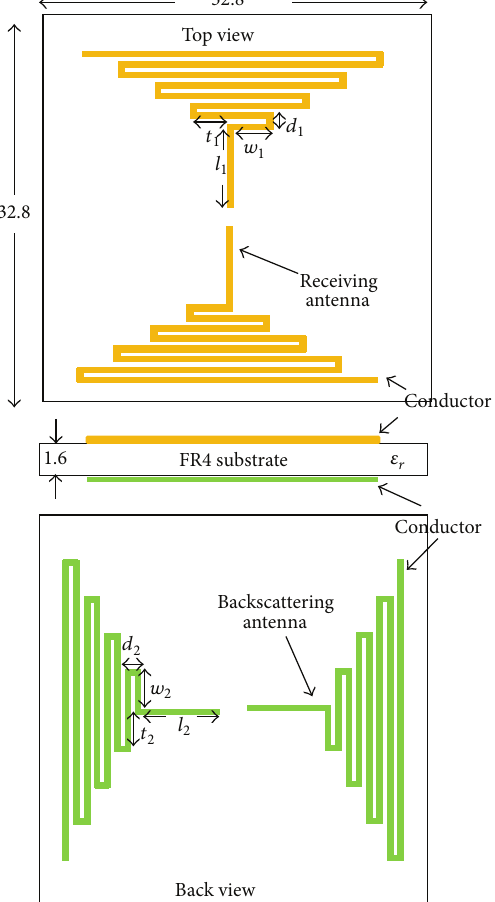
Figure 4: The benchmarking configuration of the dual-antenna